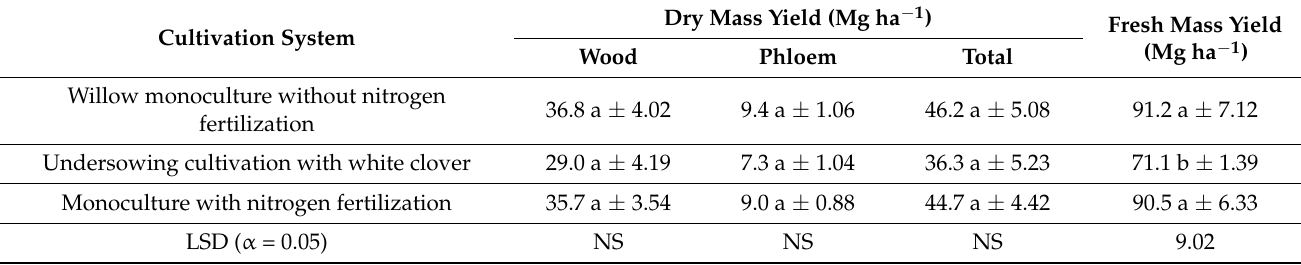
Table 9. Comparison of yielding in monoculture and willow undersowing cultivation 5 years after planting. Cultivation System Willow monoculture without nitrogen